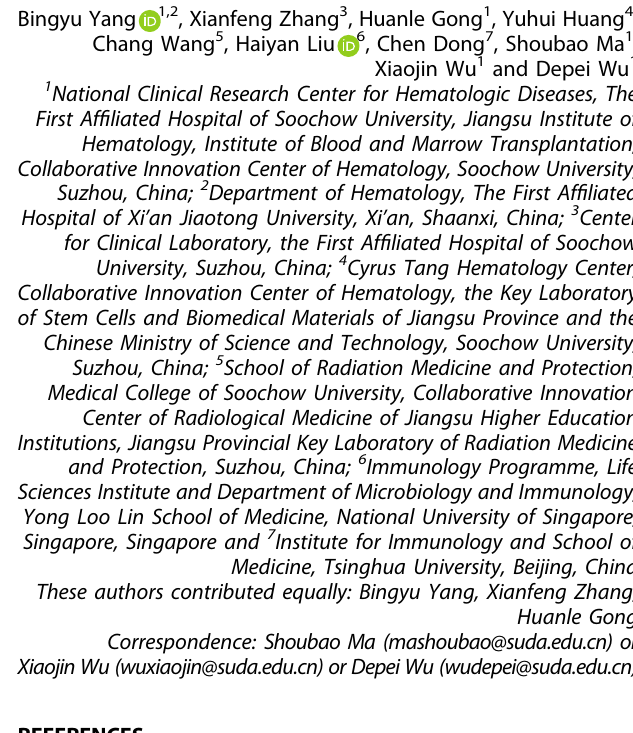
Fig. 1 High stearic acid diet (HSAD) modulates gut microbiota and aggravates acute graft-versus-host disease (aGVHD). a Survival of BALB/c recipient mice treated with normal diet (ND) or high stearic acid diet (HSAD) received bone marrow transplantation (BMT) from either syngeneic or allogeneic C57BL/6 donors. b Representative images and histopathological aGVHD scores for each aGVHD target organ on day 7 after allo-BMT, including skin, liver, lung, small intestine, and colon. Scale bars, 100 µm. c Survival of ND and HSAD recipients after allo-BMT treated with antibiotics (Abx) in drinking water. d Survival of ND and HSAD recipients after allo-BMT treated with fecal microbiota transplantation. e Taxonomic cladogram obtained from linear discriminant analysis effect size (LEfSe) showing bacterial taxa (phylum,